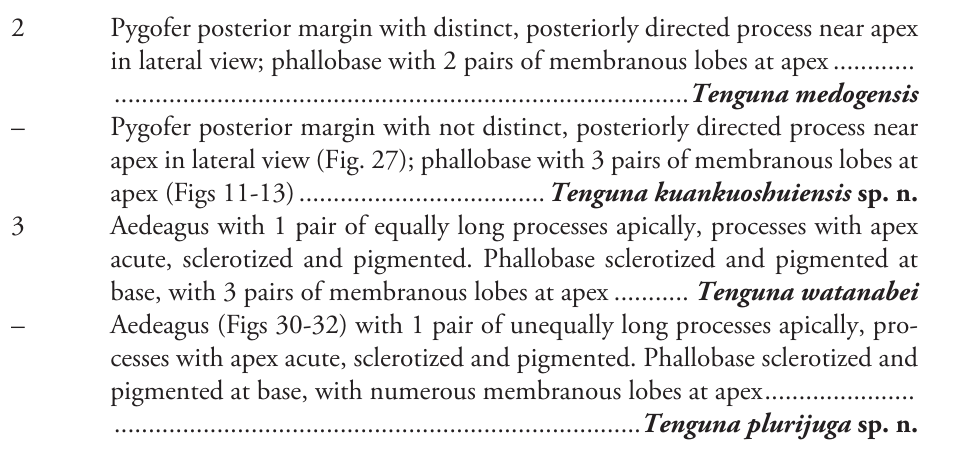
Measurements. ♂ , BL: 13.1–14.1 mm; HL: 1.7–1.8 mm; HW: 1.5–1.6 mm; FWL: 9.9–10.3 mm. ♀ , BL: 15.2–16.3 mm; HL: 1.8–1.9 mm; HW: 1.6–1.8 mm; FWL: 12.3–12.9